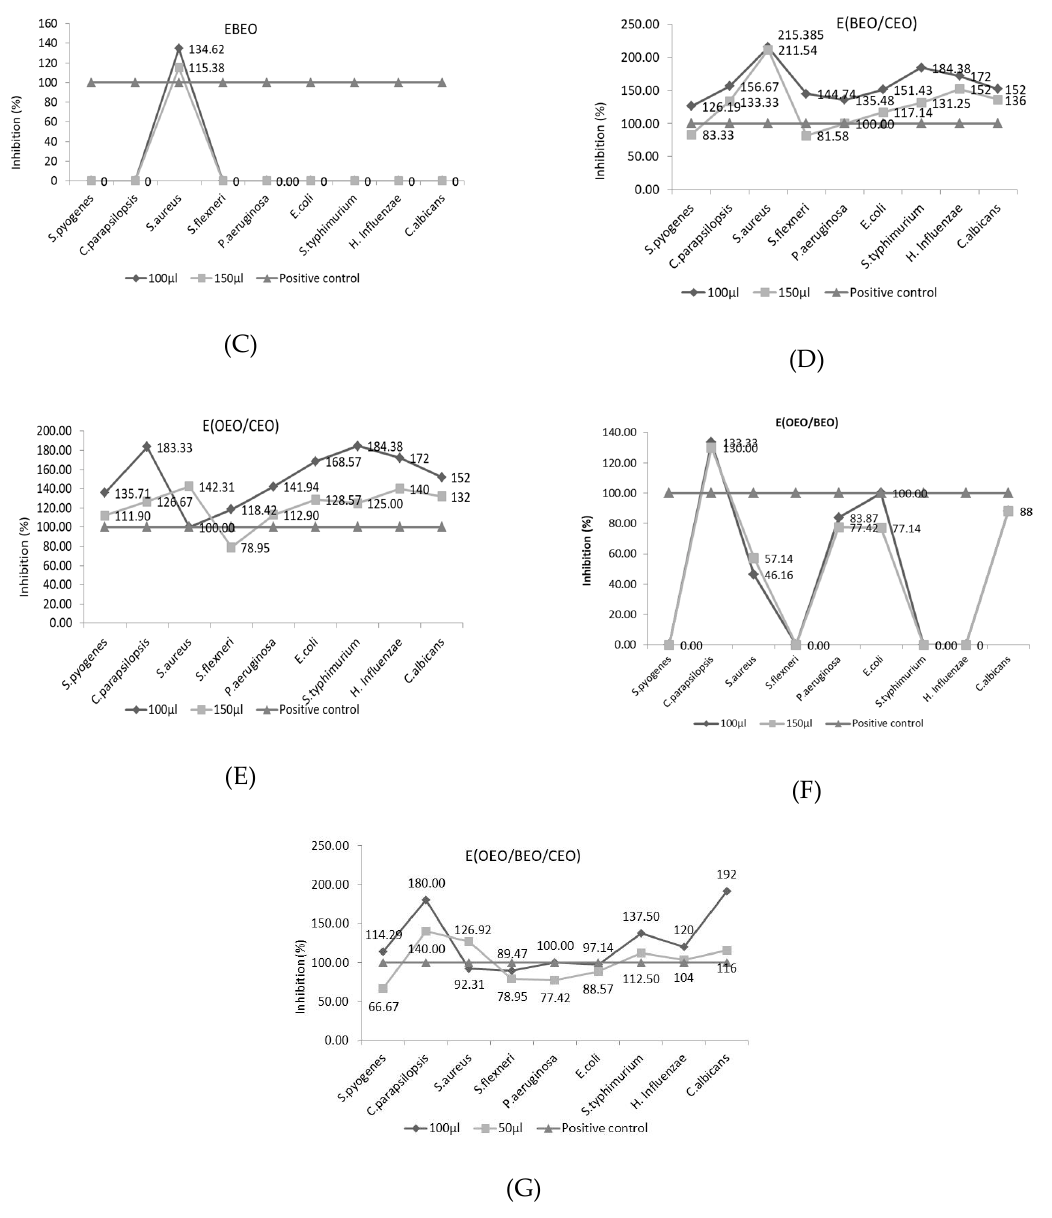
( E ) E(OEO / CEO), ( F ) E(OEO / BEO), ( G ) E(OEO / BEO / Figure 2. Inhibition rate (%) of natural preparations ( A ) ECEO, ( B ) EOEO, ( C ) EBEO, ( D ) E(BEO/CEO), ( E ) E(OEO/CEO), ( F ) E(OEO/BEO), ( G ) E(OEO/BEO/CEO).